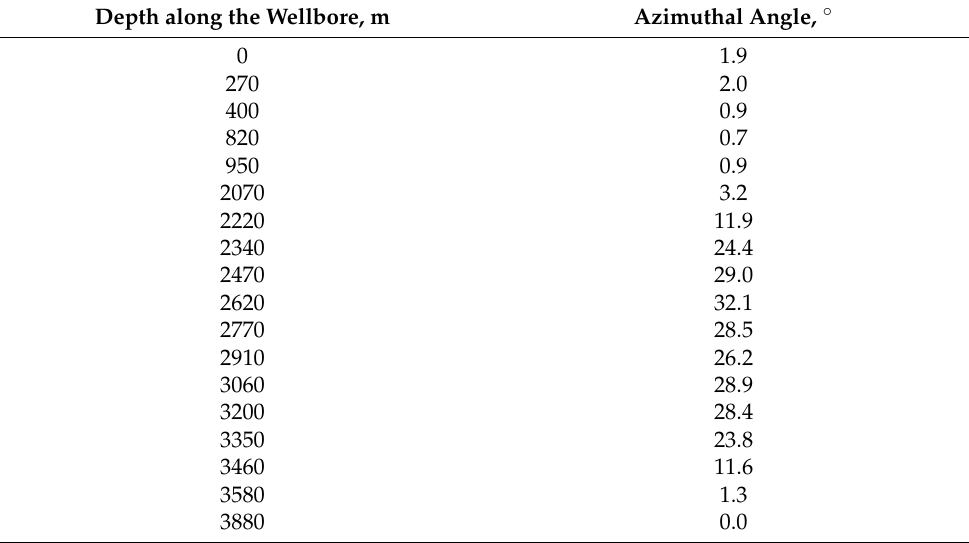
Table 2. Well geometry.